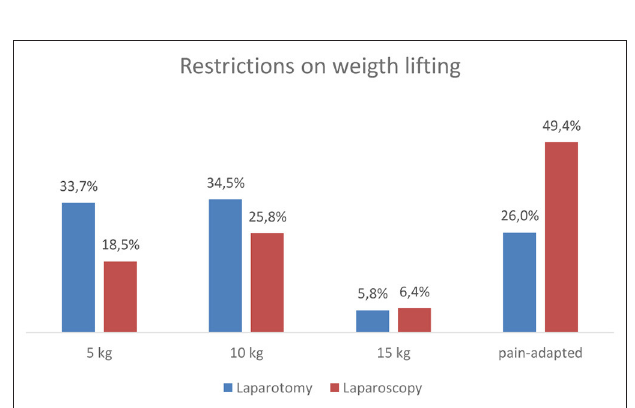
FIGURE 3 | Given recommendations on weight lifting after laparotomy and